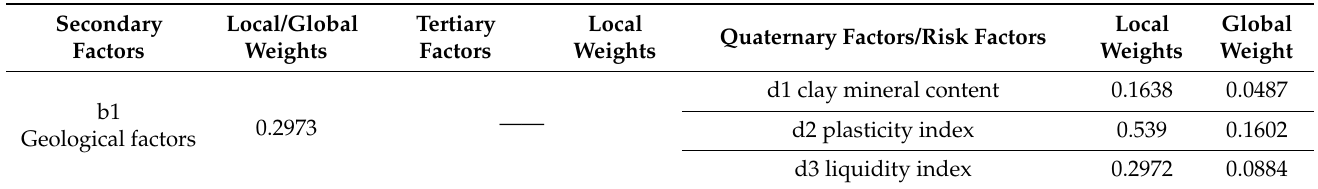
Figure 4. Bar chart of global weights of risk factors. d1 – d22 indicate the risk factors and b1 – b3 imply secondary factors in Table 4. Weights of d2 plasticity index, d3 liquidity index, d15 cutterhead torque, and d16 cutter thrust force surpass other factors significantly. Table 4. Weight of factors in different levels (secondary, tertiary, quaternary) retrieved from AHP analysis on mud cake formation. Local weight is the weight among other parameters in the same level. Global weight implies the total contribution to the primary factor, mud cake